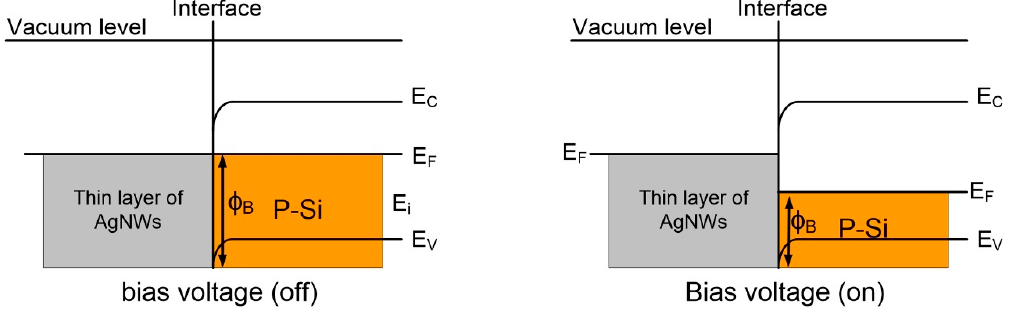
Figure 16. Energy-band diagram of AgNWs/P-Si heterostructure.